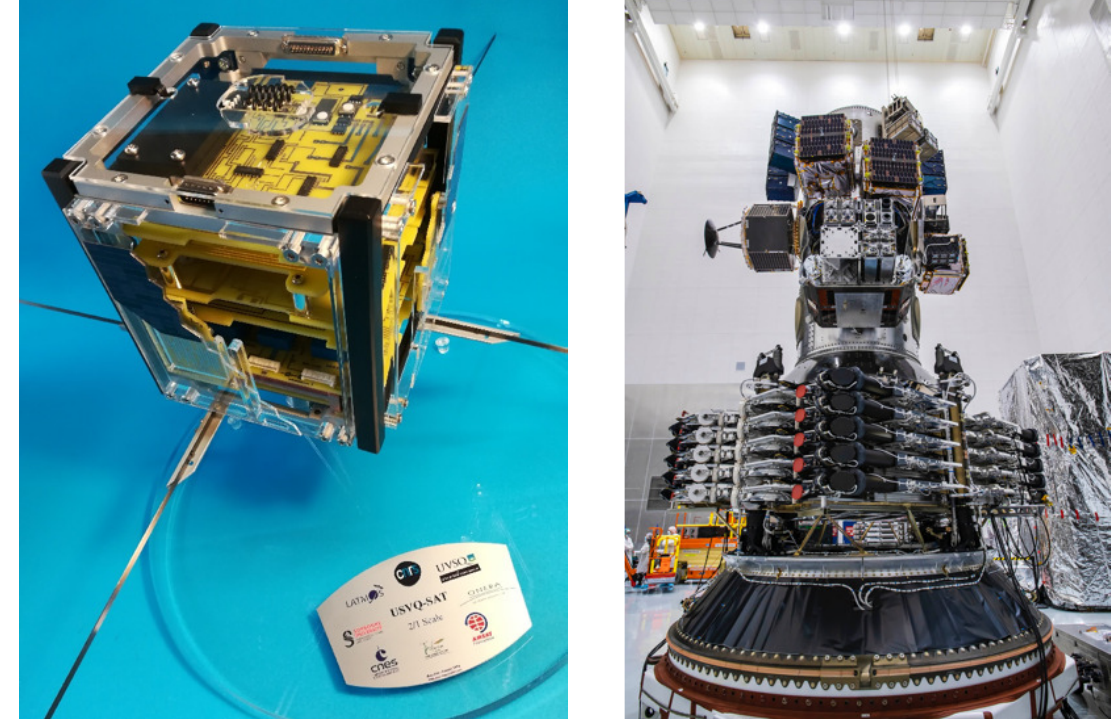
Figure 1. ( Left ) Representative mockup of the UVSQ-SAT satellite. ( Right ) Transporter1 mission (SpaceX) with 143 commercial and government satellites on-board, including UVSQ-SAT. Credits: